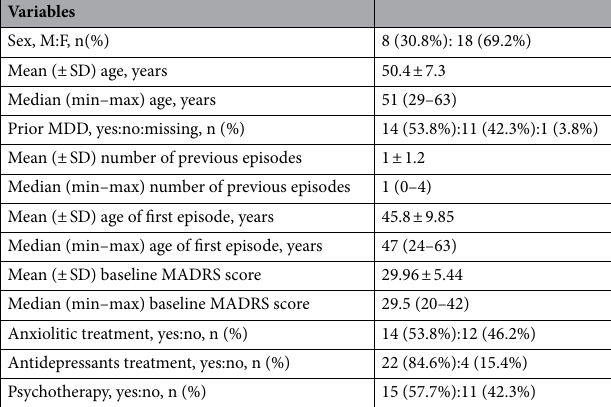
Table 1. Baseline demographic and clinical characteristics.